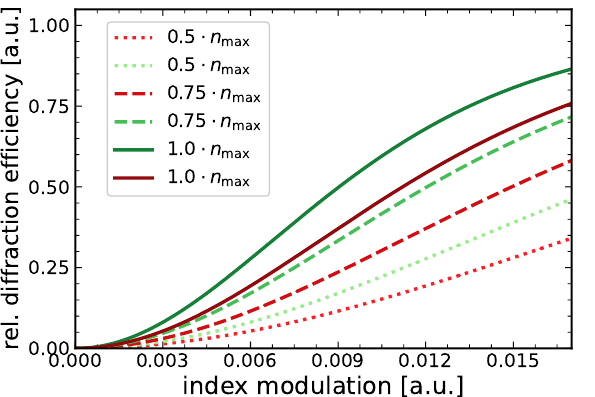
Figure 3. Theoretical diffractive characteristics of polychromatic holograms based on the N -PSM model according to Equation (4). The graphs outline recording scenarios assuming different frac- tions of the maximum index modulation n max being consumed of polychromatic holograms with holographic functions in the red and green spectral